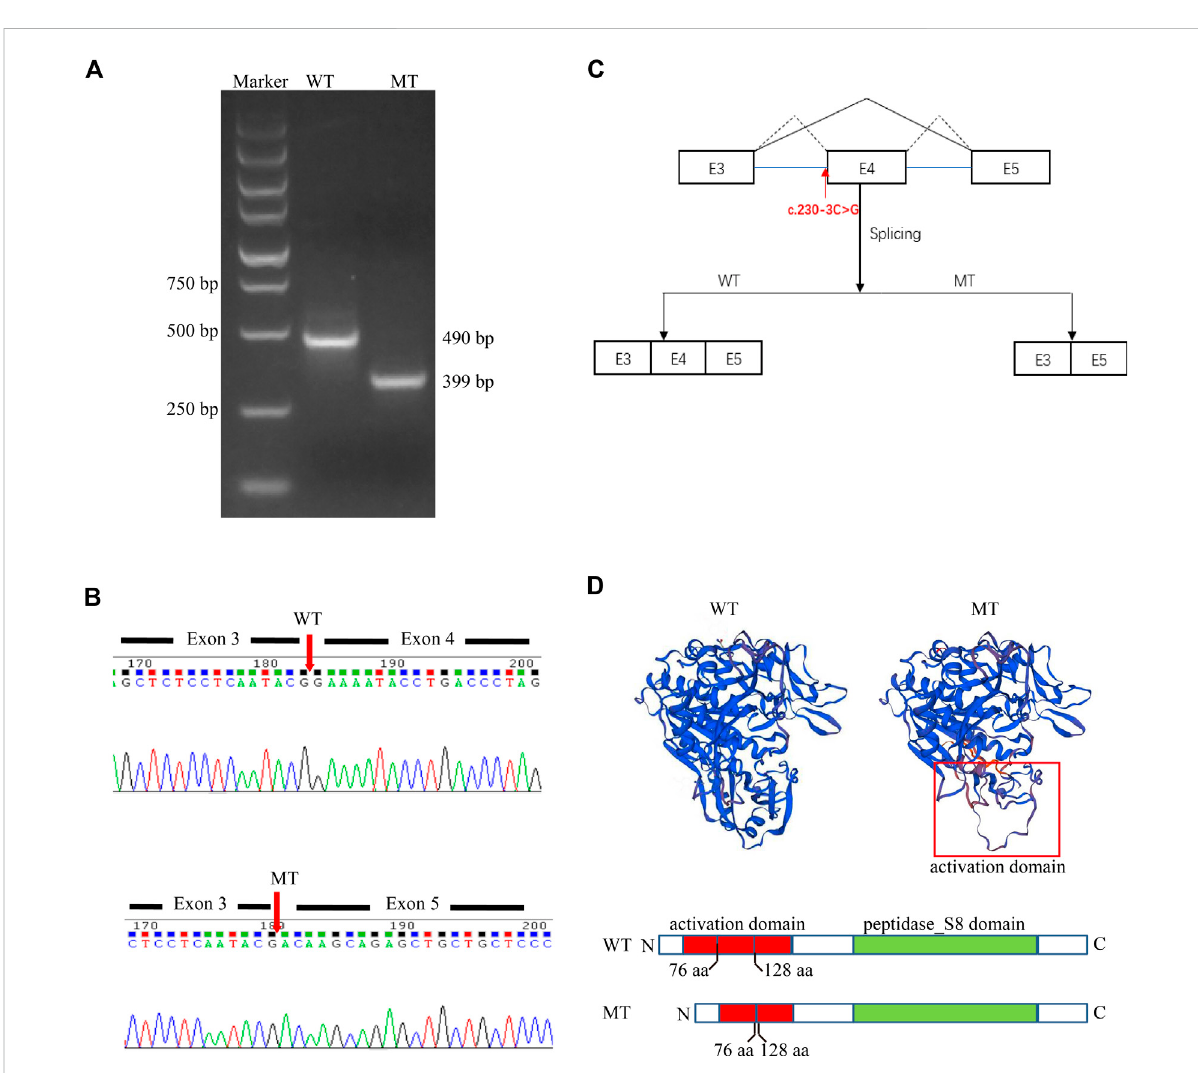
showingthecompleteskippingoftheexon4duetotheaberrantsplicinginducedbythevariantc.230-3C > Gvariant. (D) Proteindiagramandprotein modeling with SWISS-MODEL